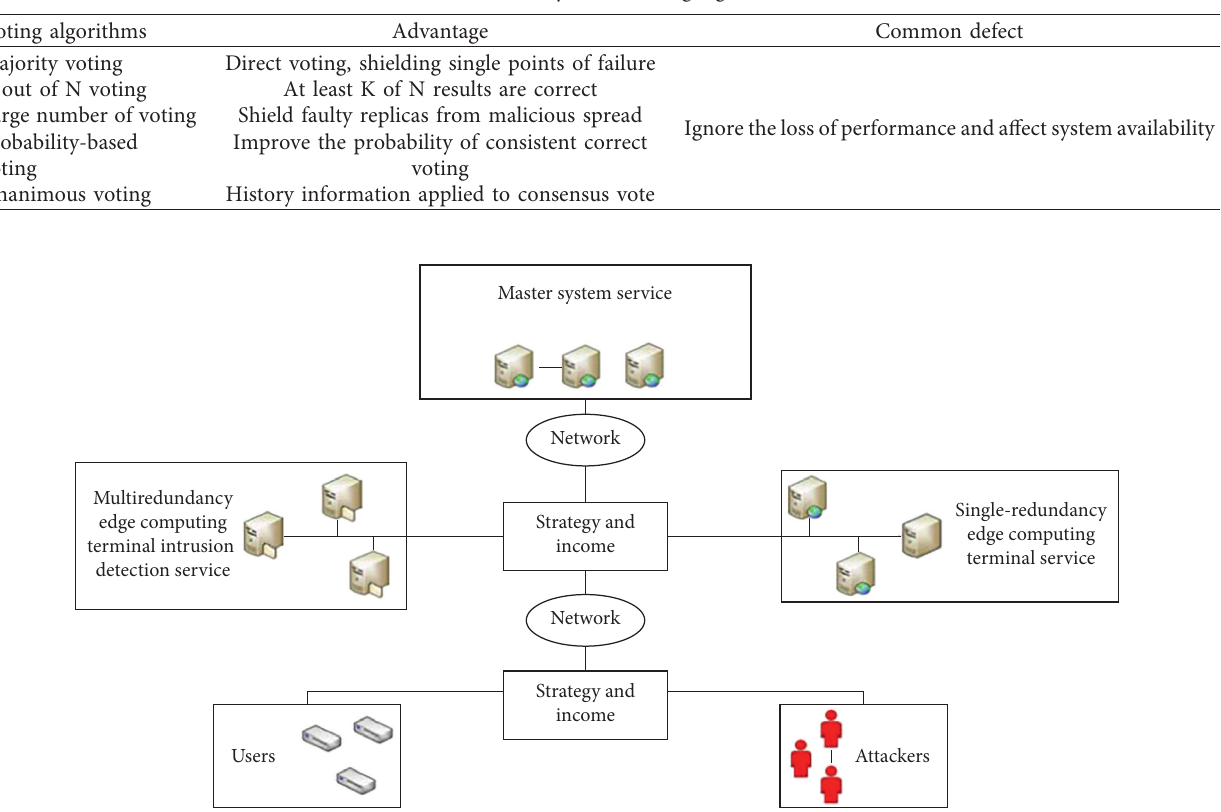
Table 1: Summary of the voting algorithms.